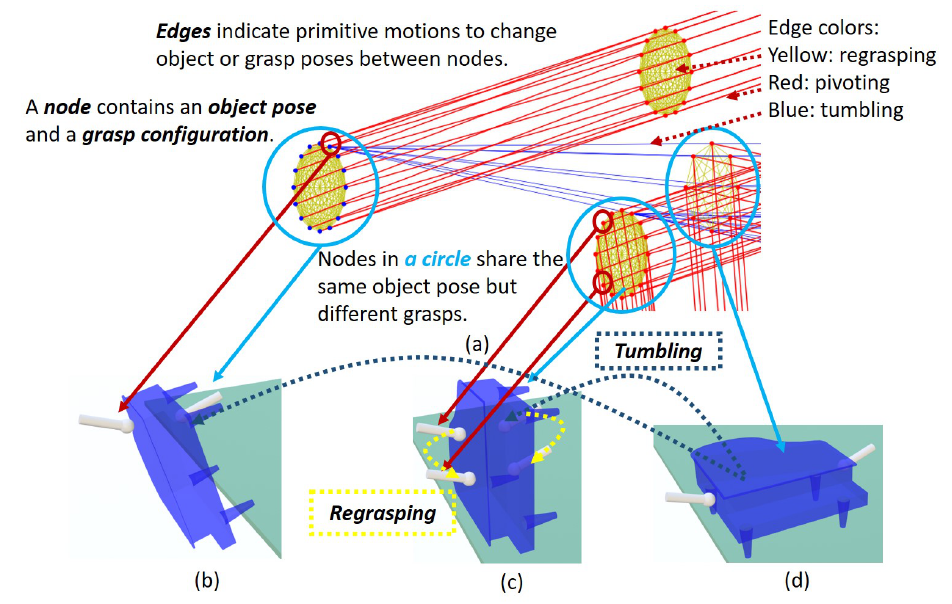
Figure 11. ( a ) Portion of the graph in the rectangle depicted in Figure 10b. The nodes within the light blue circle share the same object pose and each node indicates the grasp configuration for the object pose. Nodes are connected by edges which correspond to primitive motions. ( b ) An object pose and a corresponding grasp pose. ( c ) Two grasp poses can be changed by the yellow edge connecting them. ( d ) The object pose in ( d ) can be changed to ( b ) or ( c ) by